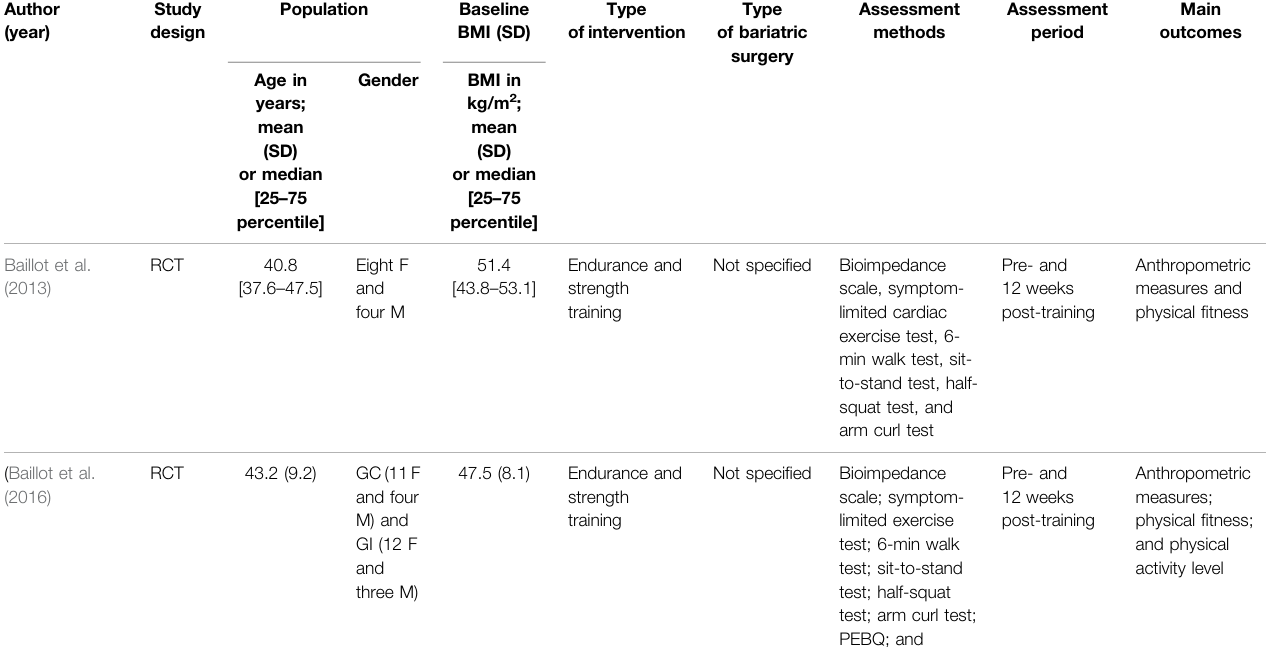
TABLE 2 | Baseline characteristics of studies included in the